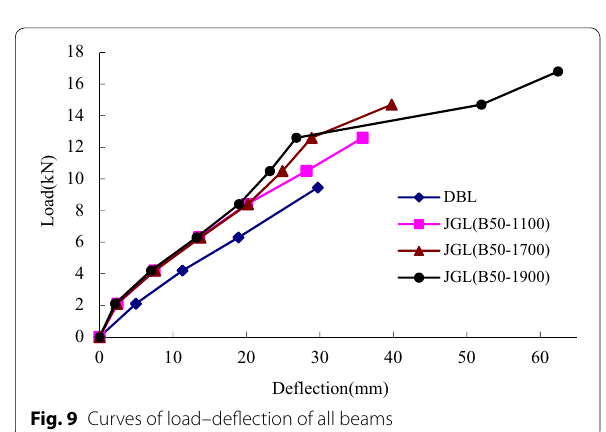
Fig. 9 Curves of load–deflection of all